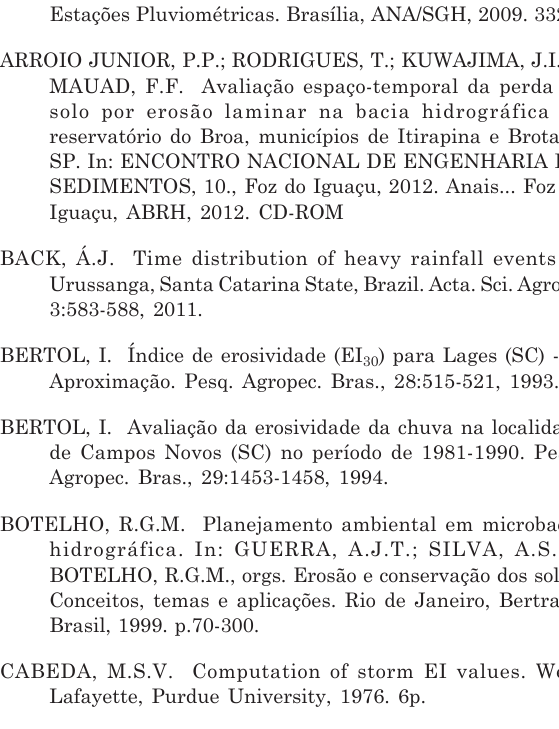
279,1 mm, de não erosivas.